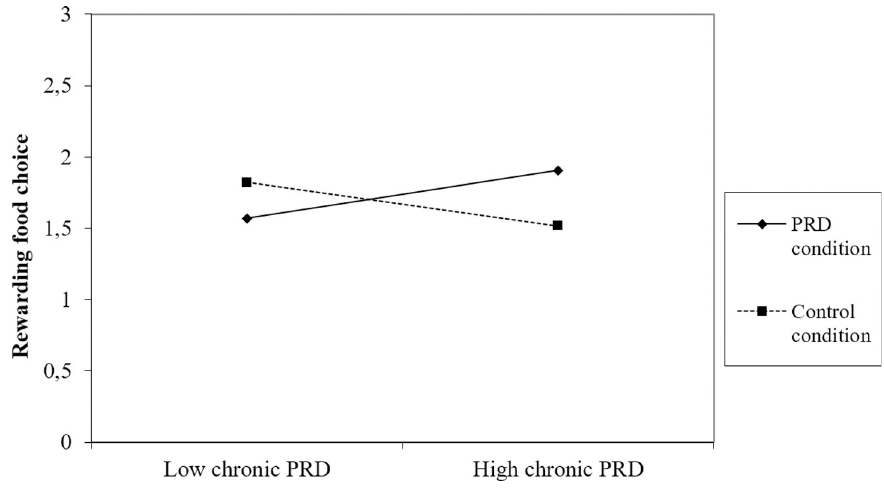
Fig 2. Interaction effect observed in Study